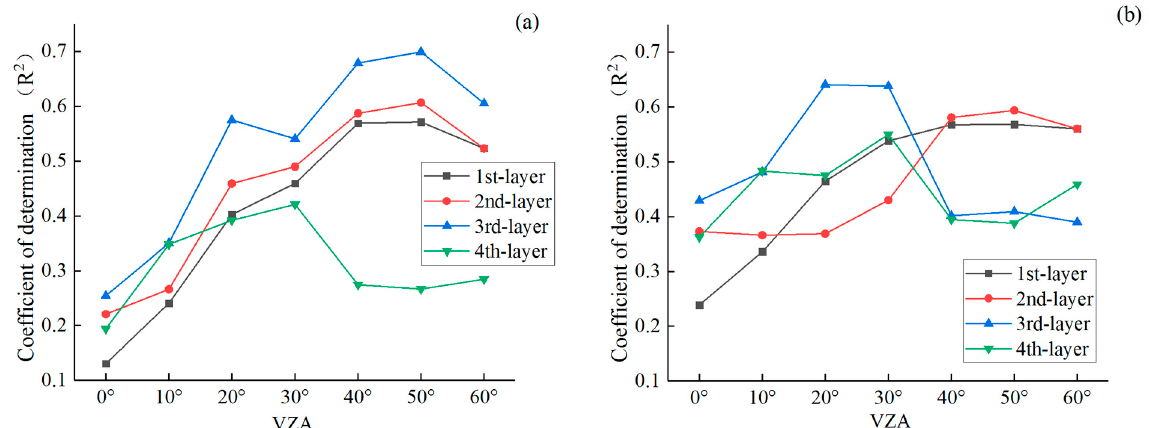
Figure 5. Coefficients of determination between SPAD values and indices under different layers and VZAs: ( a ) Eucalyptus pigment index (EPI) and ( b ) red edge inflection point (REIP) index.